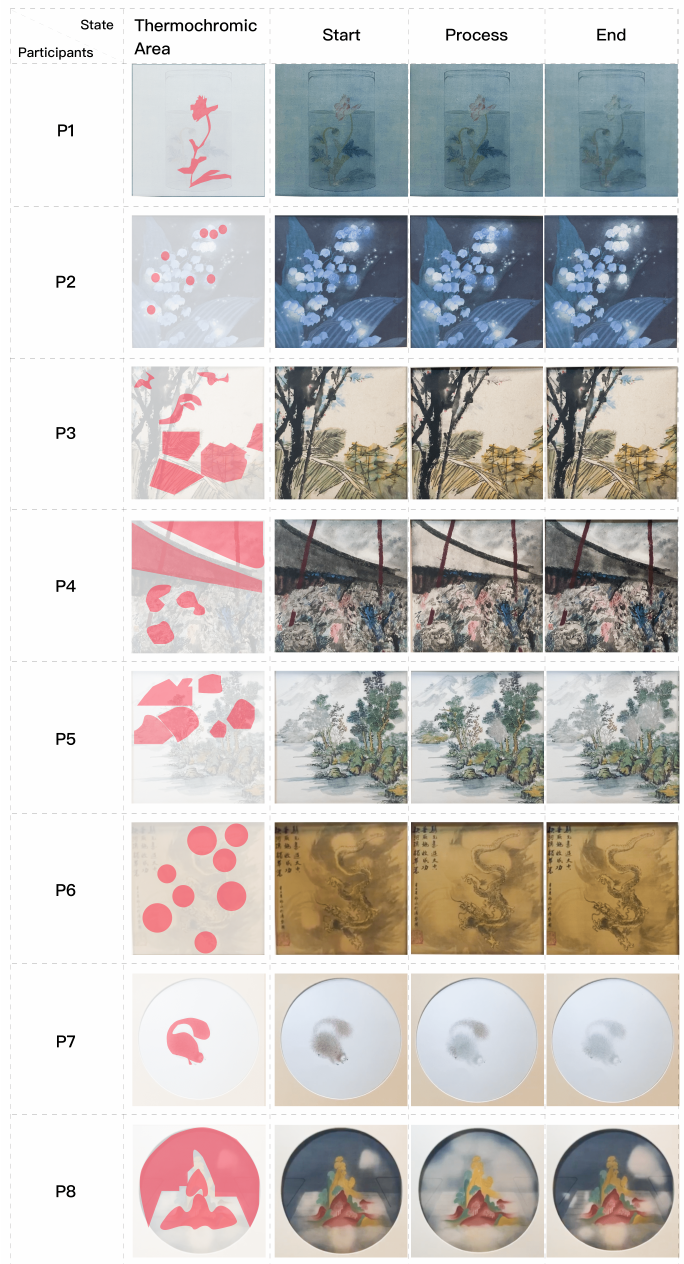
Figure 12. Thermochromic paintings created by the eight participants independently using